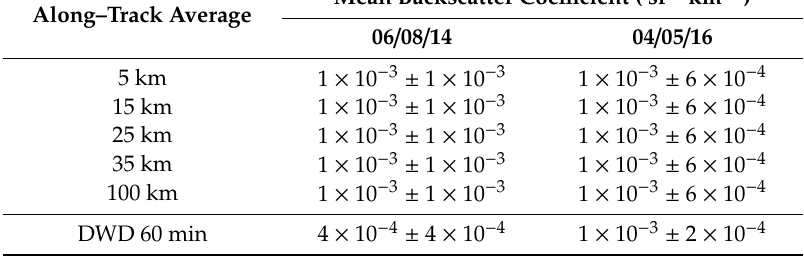
Table A2. Mean backscatter coe ffi cient values with the respective standard deviation for all CALIOP along–track averages over Harzgerode–DWD. The values are related to the case studies from Section